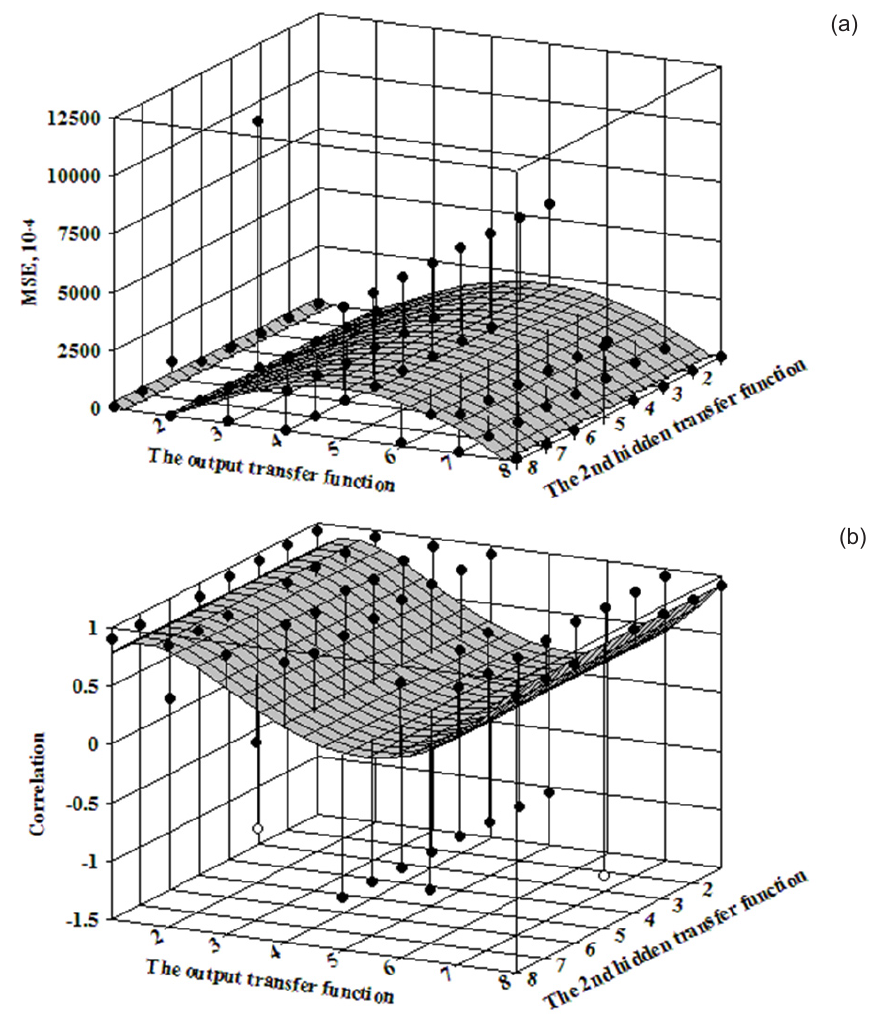
Figure 2. The influence of transfer functions on the performance of neural model, represented by MSE (a) and correlation